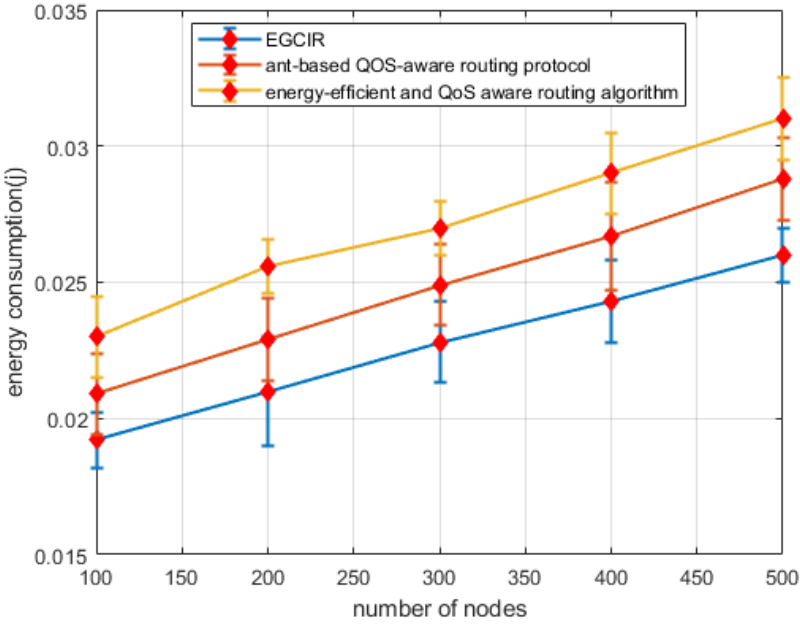
Figure 5. Impact of the nodes and energy consumption.